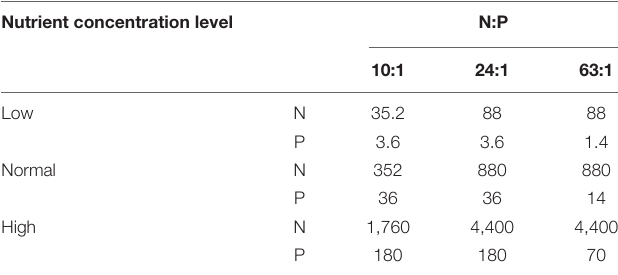
TABLE 1 | N and P concentrations ( µ mol L − 1 ) and their molar ratios in bi-algal competition experiments. Nutrient concentration